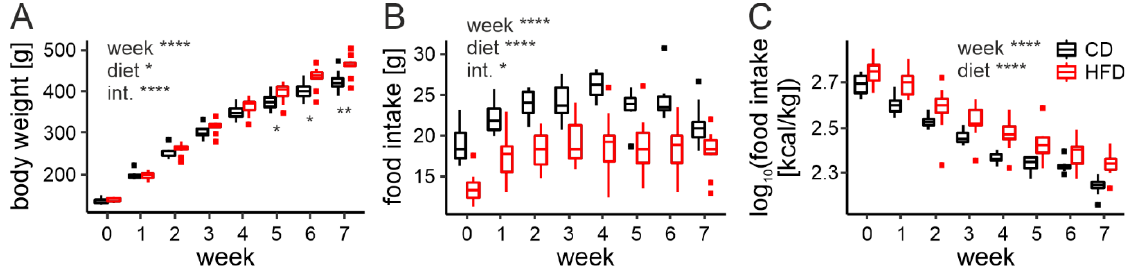
Figure 1. Body weight gain and feeding assessment. ( A ). Body weight gain across 7 weeks on either control (CD) or high-fat diet (HFD; week: F8,18 = 768.27, p < 0.0001; diet: F1,18 = 5.08, p = 0.037; interaction: F7,18 = 16.11, p < 0.0001). Differences between the diets observed from week 5 onwards (t18 = 2.37, p = 0.029). ( B ). Daily food intake in grams across 7 weeks on either CD or HFD (week: F7,18 = 35.92, p < 0.0001; diet: F1,18 = 45.13, p < 0.0001; interaction: F7,18 = 3.00, p = 0.028). ( C ). Daily food intake in kcal/kg body mass across 7 weeks on either CD or HFD (week: F7,18 = 183.84, p < 0.0001; diet: F1,18 = 30.52, p < 0.0001, interaction: F7,18 = 2.33, p = 0.07). * p < 0.05, **** p < 0.0001. Box- and-whisker plots present median value, interquartile range (IQR; box) and the minimum-to- maximum range of values, not exceeding 1.5 * IQR (whiskers). Data points outside this range are plotted individually as outliers.